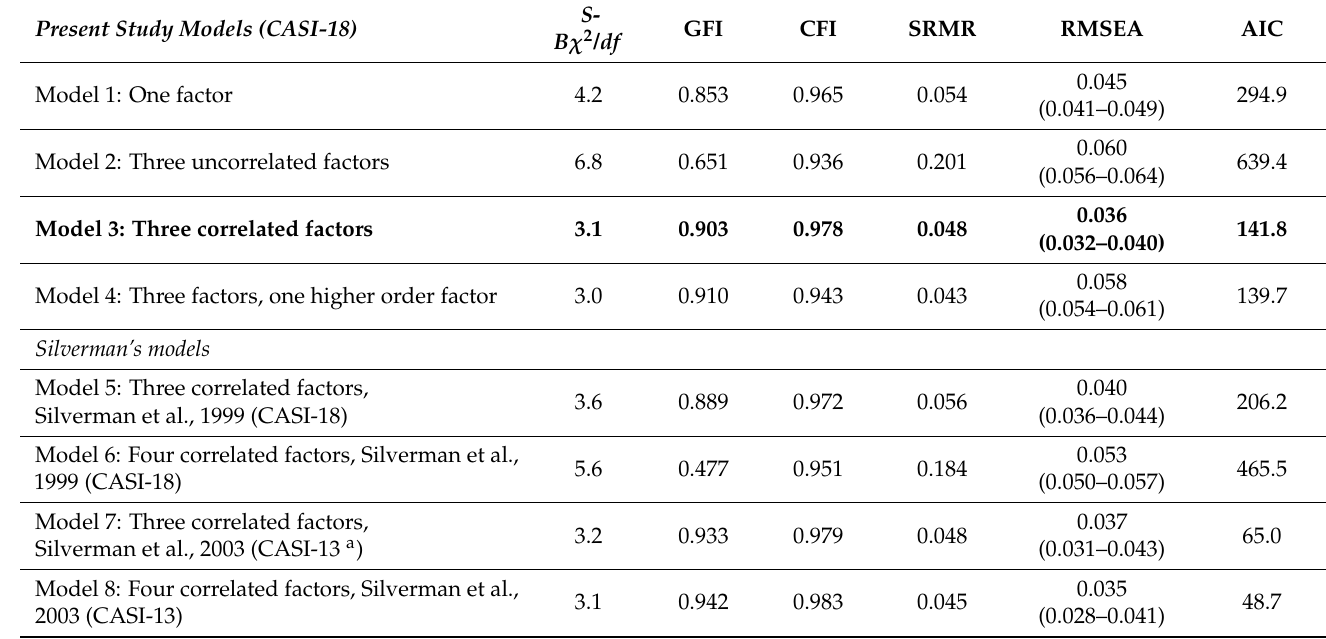
Table 3. Confirmatory factor analysis of the CASI: goodness-of-fit indices for the tested models ( N =